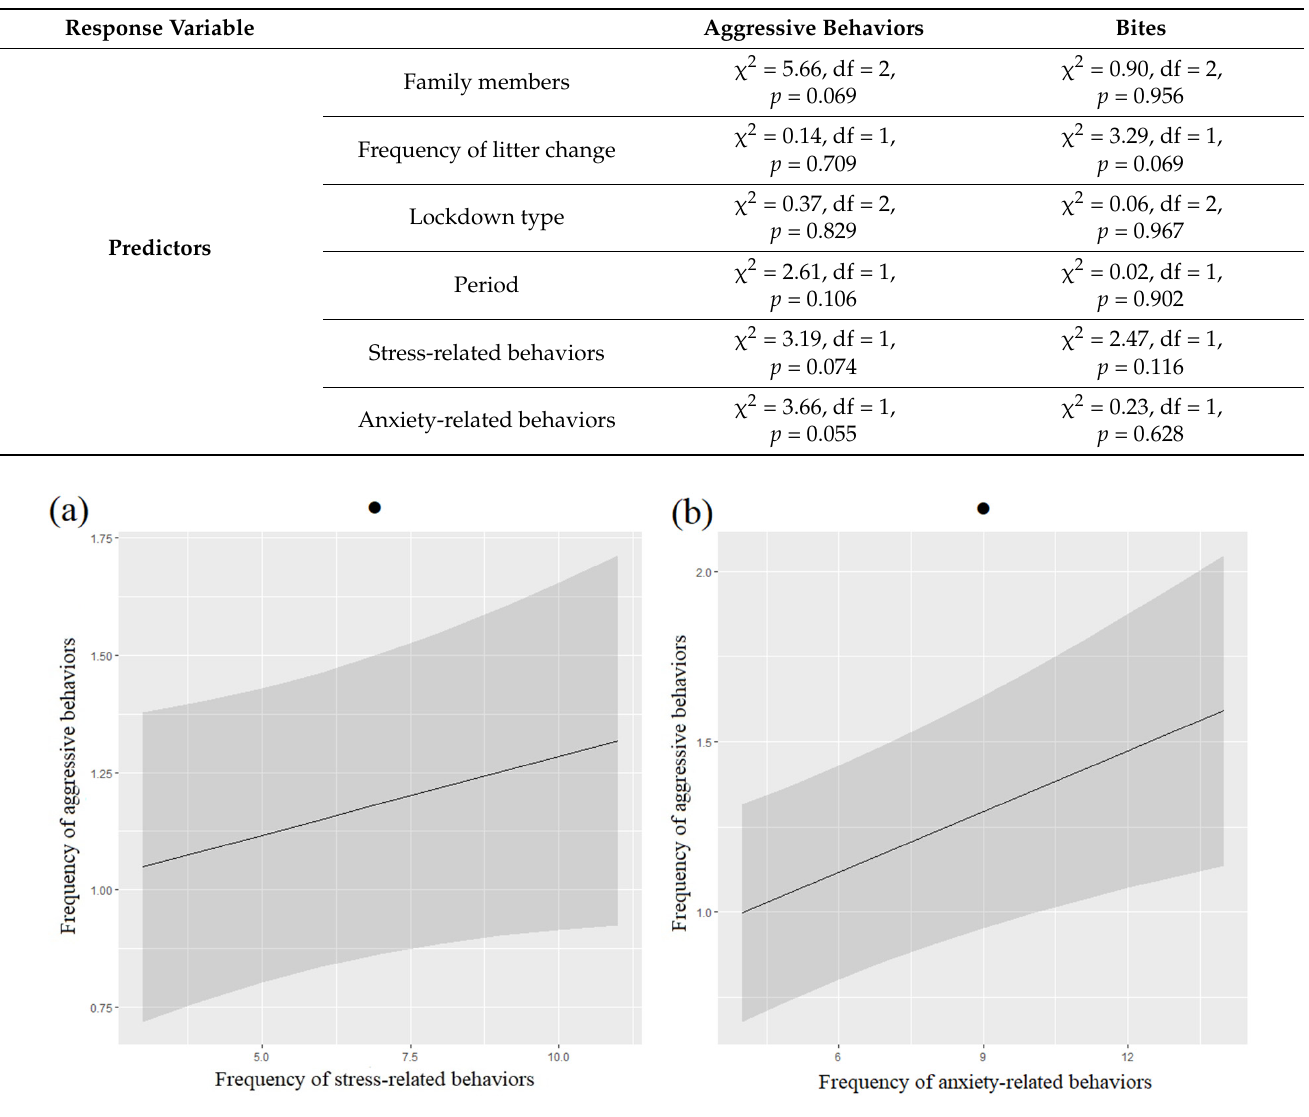
Figure 8. Means and 95% confidence intervals of cats’ aggressive behaviors’ frequency depending on the frequency of stress-related behaviors ( a ) and frequency of anxiety-related behaviors ( b ), ex- tracted from ordinal logistic regressions. ● : p < 0.10, Wald chi-squared tests.